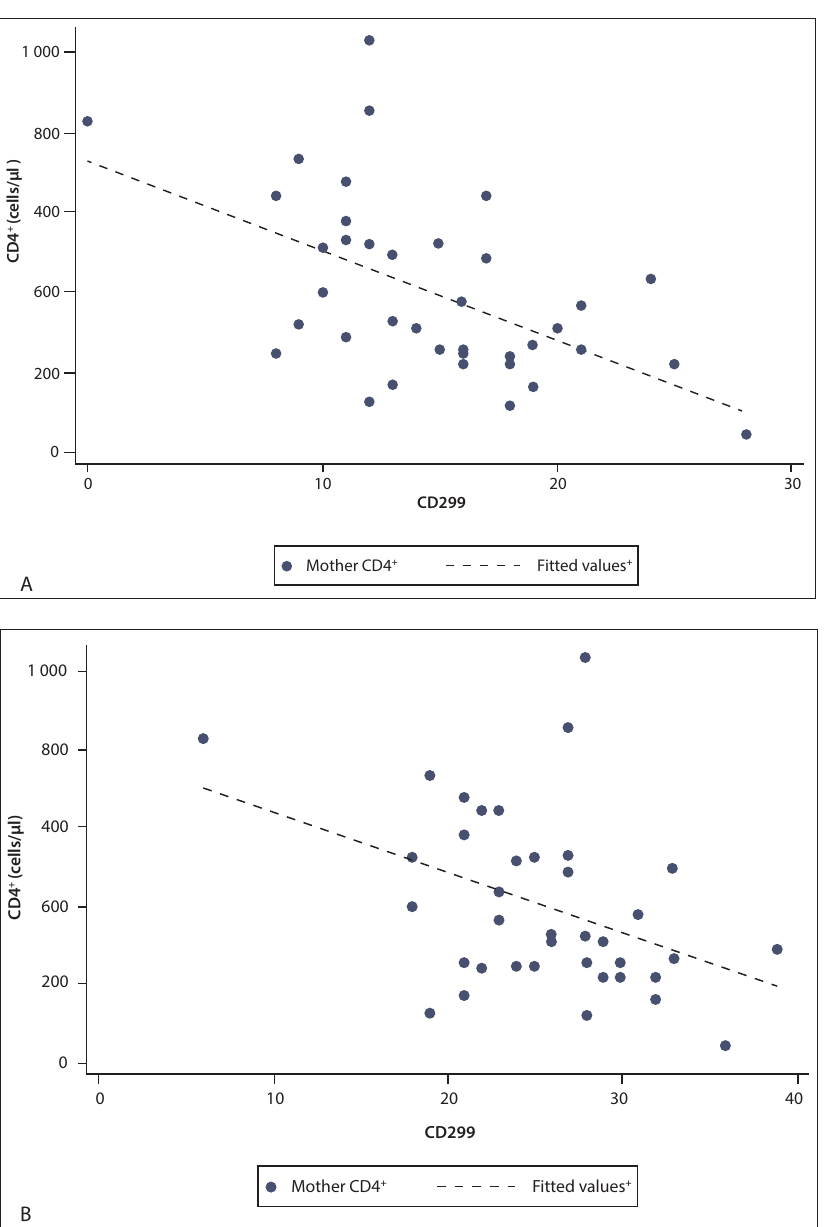
Fig. 5. A. CD4 + v. DC-SIGNRs (CD299) showing a statistically significant inverse correlation, the higher the expression, the lower the CD4 + count; B. CD4 + v. DC-SIGN (CD209) showing a statistically significant inverse correlation, the higher the expression, the lower the CD4 + count. (DC-SIGNR = human dendritic cell-specific intracellular adhesion molecule-3 (ICAM3)-grabbing non-integrin-related